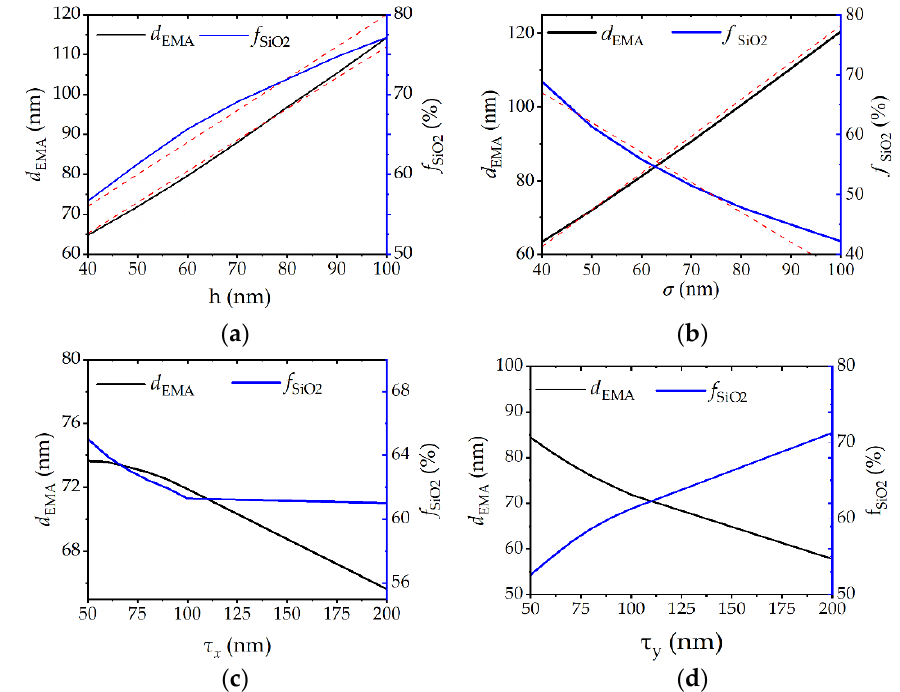
Figure 9. Fitting results of ellipsometric parameters of rough surface simulated by FDTD under different topographic feature parameters.